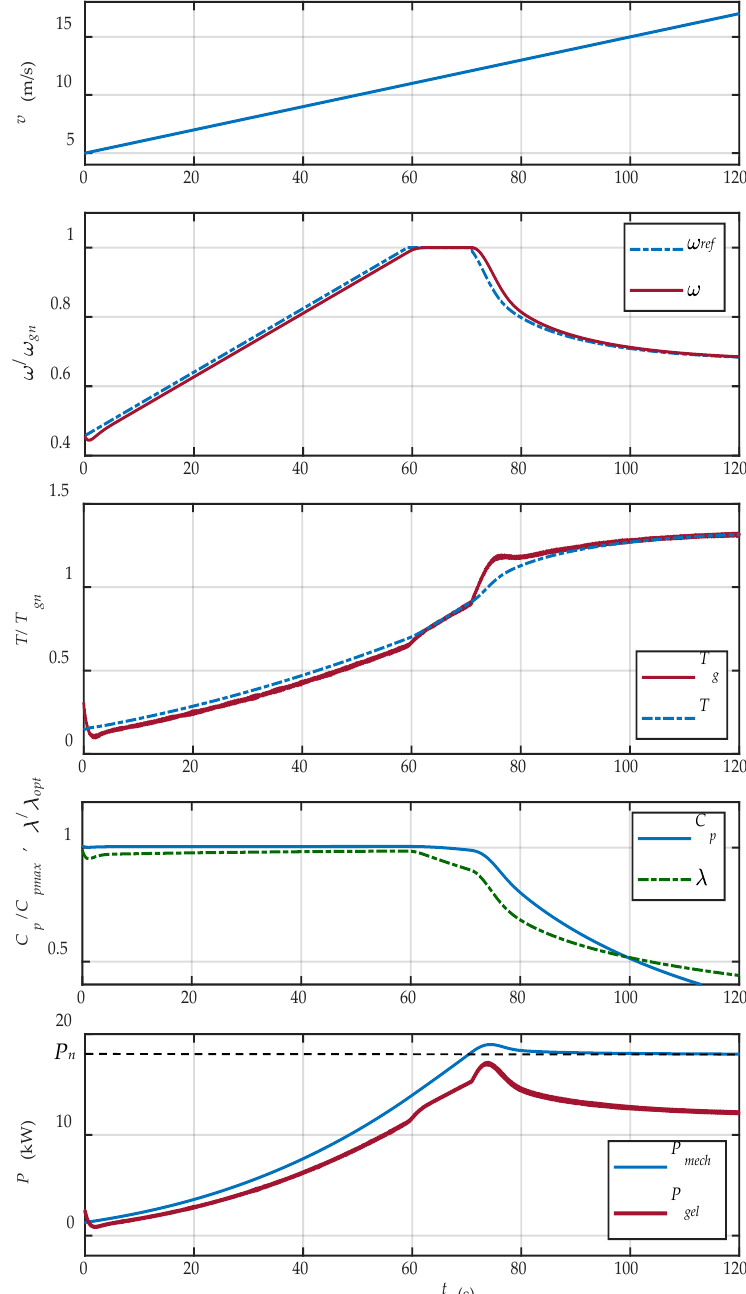
Figure 14. Plots of the WECS variables for the wind speed slowly, linearly growing with the slope Figure 14. P lots of the WECS variables for the wind speed slowly , linearly growing with the slope 0.1 0.1 m / s 2 m/s 2 .